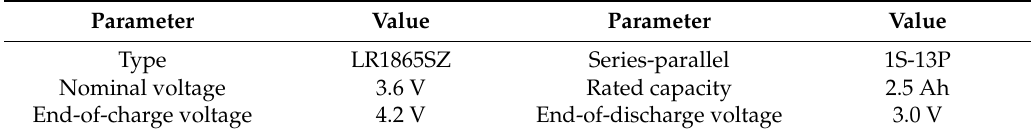
Figure 6. The battery testing currents. The available capacity of the tested LIB module at different C-rates is shown in Table 2. It can be seen that the battery released 96.12% of the maximum capacity at 0.2 C; while the battery released 94.52% of the maximum capacity at 1 C. When the current was further increased to 3 C, the battery only released 84.89%. The result was consistent with the “capacity nonlinear effect”, and the relationship of the available capacity and current was nonlinear. Table 2. Available capacity and discharge time at different C-rates. Discharge rate (C)